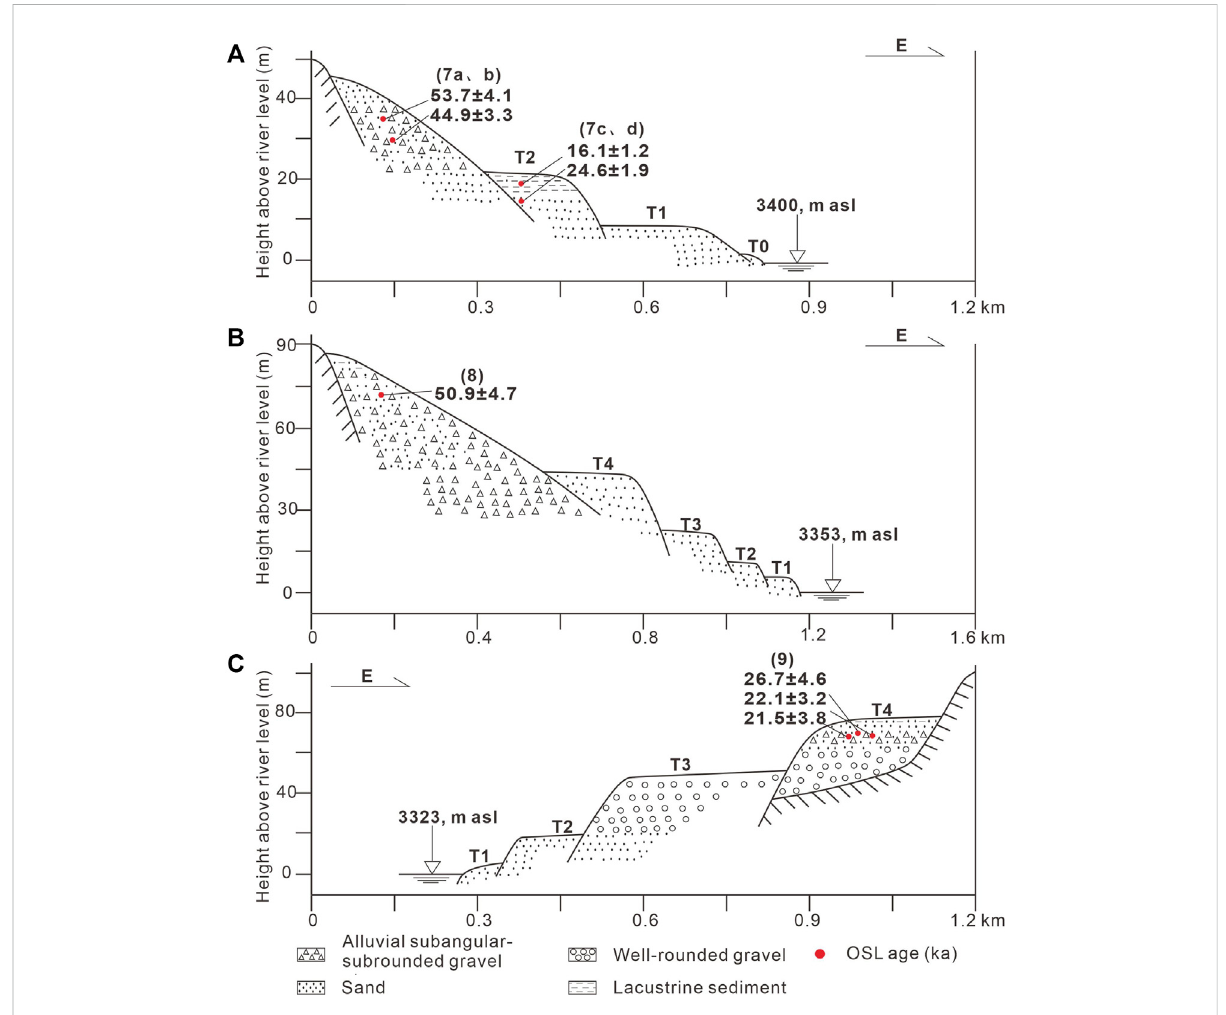
FIGURE 5 Schematic transverse sections of the terraces (sites 7 – 9), with dating